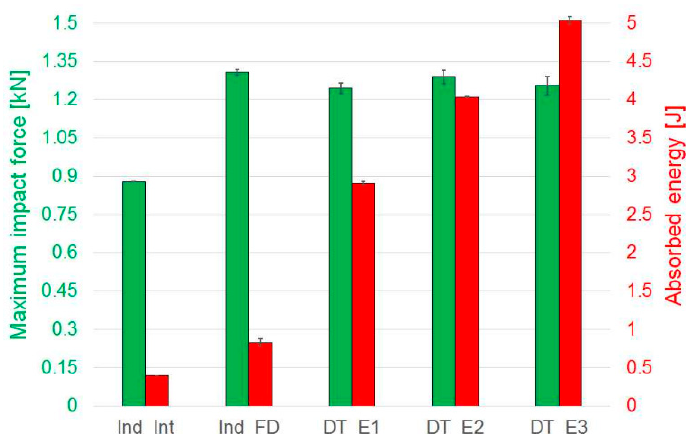
Figure 5. Indentation and impact tests: comparison of peak of force and absorbed energy. Indented Interrupted (Ind_Int) and Indented Fully Damaged (Ind_FD) specimens and samples impacted respectively at 2.2 J (DT_E1), 3.2 J (DT_E2) and 4.2 J (DT_E3). Error bars represent standard deviation.